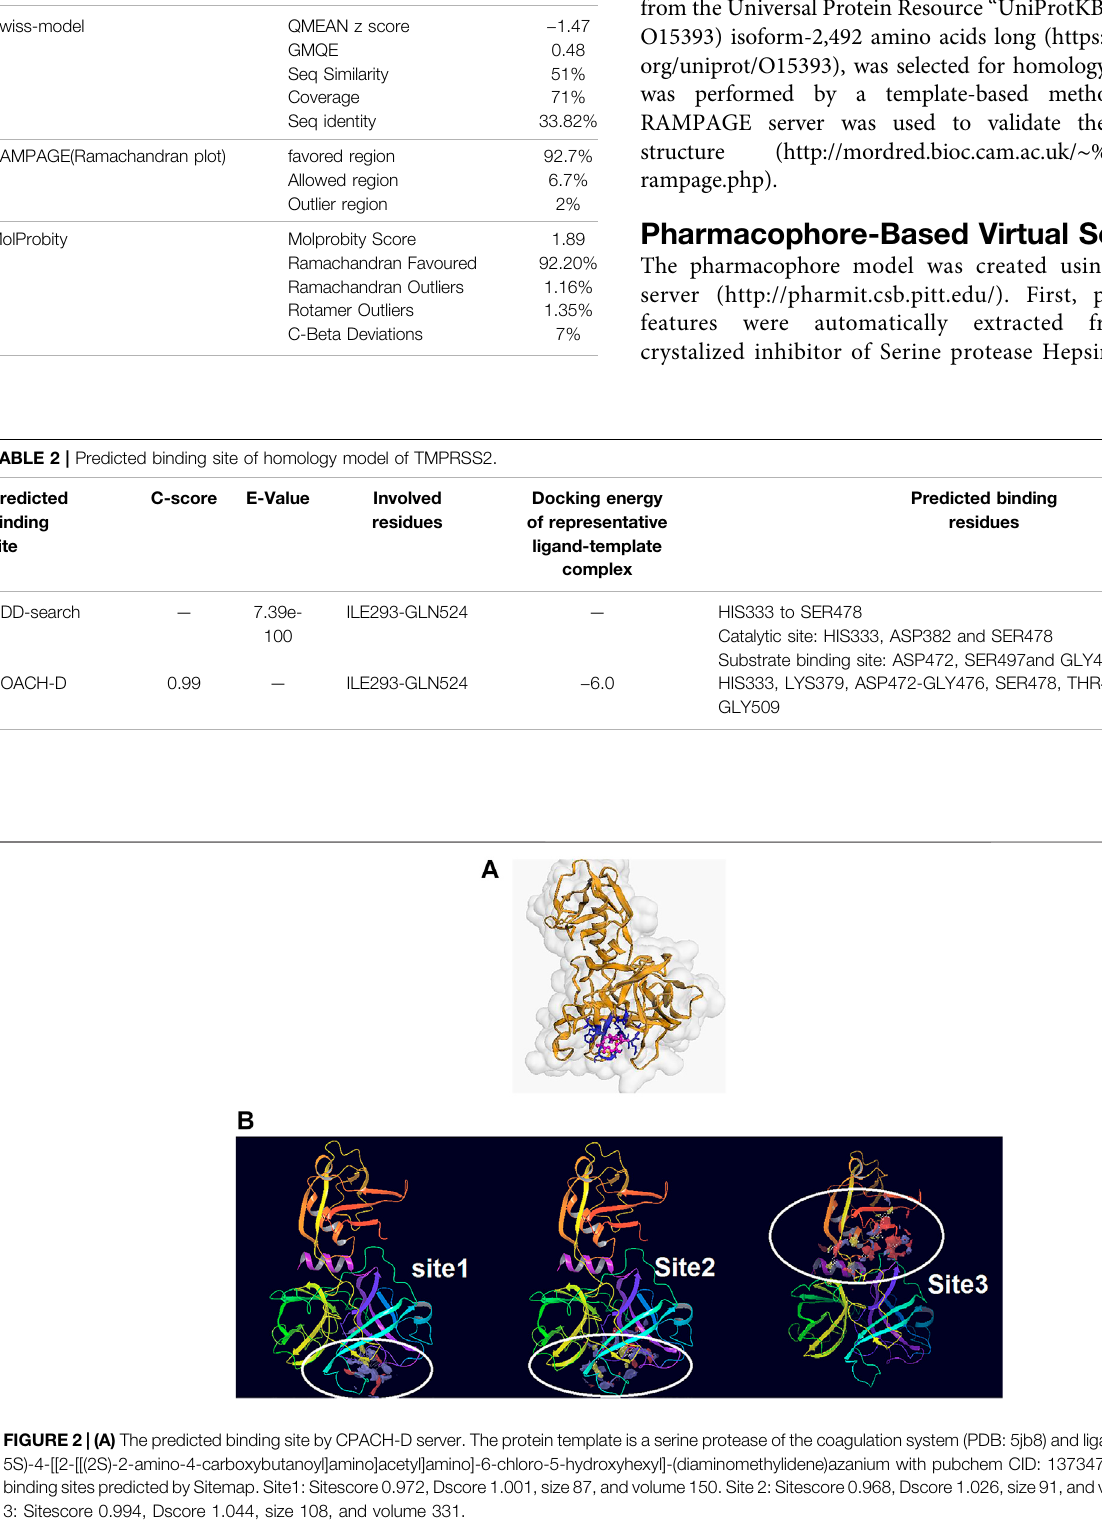
TABLE1| Homologymodelingresultsandvalidationforpredicting3Dstructureof TMPRSS2. Server/tool